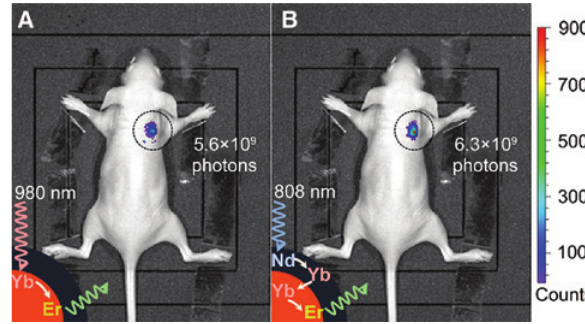
Figure 12: In vivo UC imaging of a nude mouse subcutaneously injected with NaGdF :Yb, Er@NaGdF :Nd, Yb NPs. 4 4 The images were obtained with 980 nm laser (A) and 808 nm laser (B) irradiation. Taken from [223]. Reproduced with permission of American Chemical Society. Copyright ©